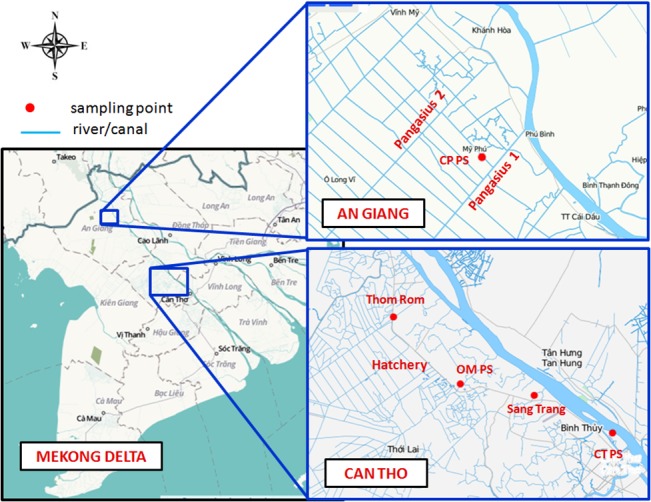
Study sites in Can Tho City and An Giang Province.
Map resource: http://www.openstreetmap.org/.